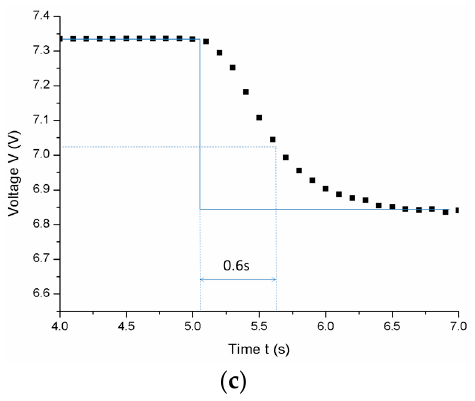
Figure 5. ( a ) Real-time response of the sensor under 0 mA and 5 mA; ( b ) Noise spectral density of the sensor; ( c ) Thermal response time of the sensor.